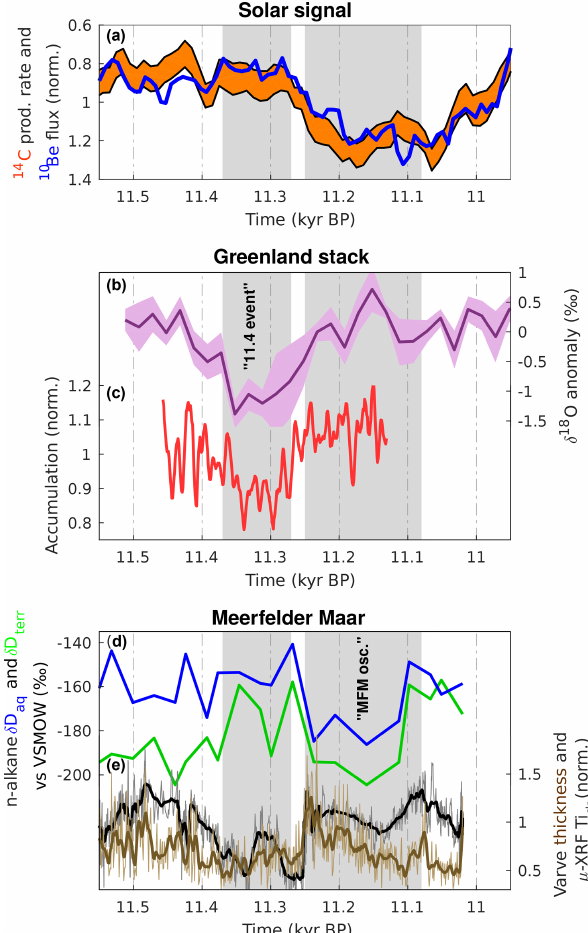
Figure 3. (a) 14 C production rate (orange envelope) and GRIP 10 Be data (blue) on a reversed y axis to indicate variations in solar activ- ity. (b) The δ 18 O stack from the DYE-3, GRIP, NGRIP, and Renland ice cores (Rasmussen et al., 2007; Vinther et al., 2009) is shown in magenta, and (c) the modeled accumulation anomalies from Ras- mussen et al. (2007) for DYE-3, GRIP, and NGRIP are shown in red. (d) The δ D data record from lipid biomarkers of MFM sedi- ments (Rach et al., 2014) is plotted in blue and green (aquatic and terrestrial), while (e) varve thickness (Martin-Puertas et al., 2012a) and varve µ -XRF Ticlr (Martin-Puertas et al., 2017) are plotted in brown and black, respectively. The gray bands depict the time of occurrence of the 11.4ka event in Greenland and of the cold os- cillation inferred from the MFM sediments (MFM oscillation). All data are plotted on the IntCal13 timescale as per Fig.